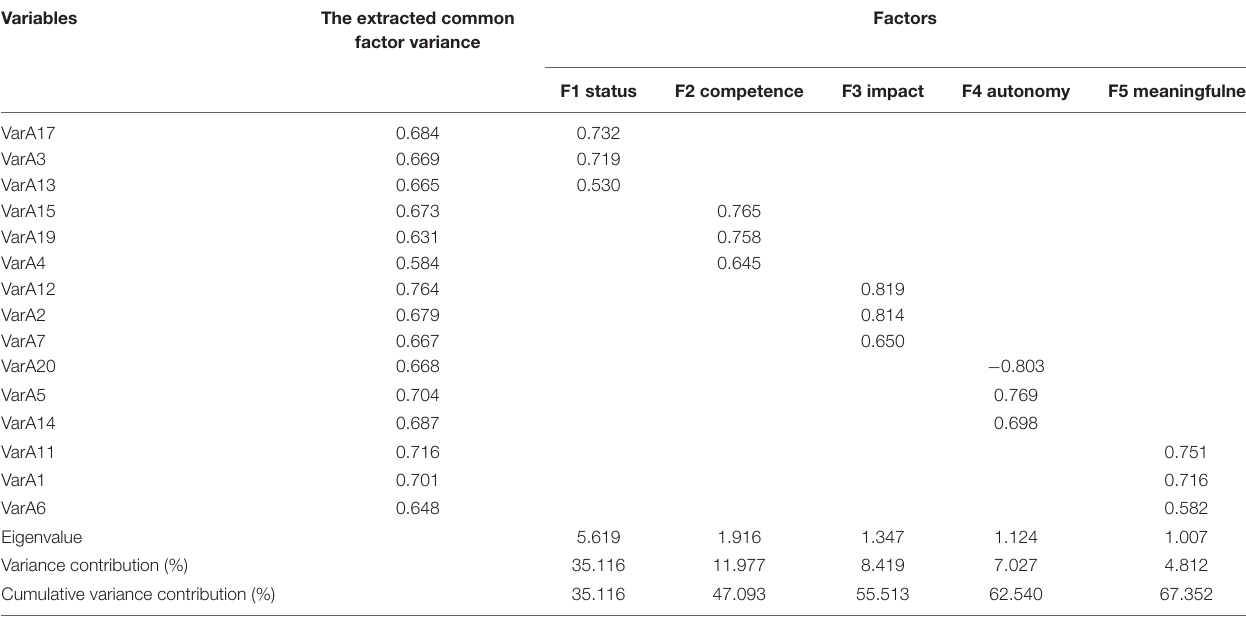
TABLE 6 | Exploratory factor analysis of the revised CETPE scale ( N = 227). Variables The extracted common factor